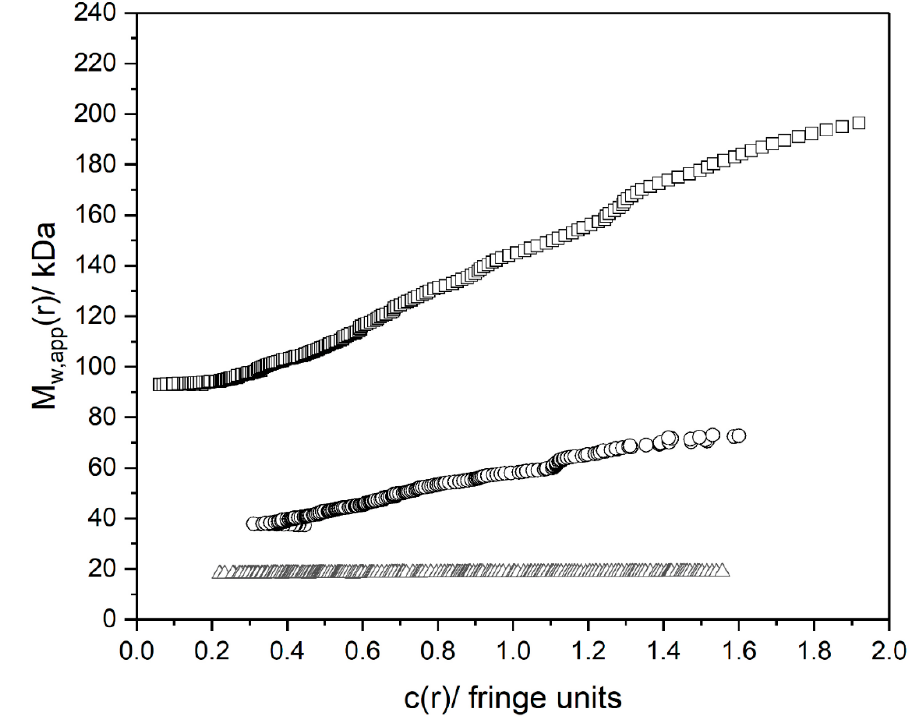
Figure 4. Sedimentation equilibrium analysis (using SEDFIT-MSTAR) on C. moschata polysaccharides. A low loading concentration (to minimise effects of thermodynamic non-ideality) of 0.4 mg/ml (~0.8 fringes in the long path-length cells) was employed. Plots of point weight average molecular weights M w,app ( r ) in kDa vs. local concentration c ( r ) (in Rayleigh fringe units) as functions of radial displacement, r, from the centre of rotation. Squares NJBTF1, Circles NJBTF2, Triangles NJBTF3. M w values (M w,app ) extrapolated to zero concentration = 92 ± 5 kDa (NJBTF1), 31 ± 2 kDa (NJBTF2), and 19 ± 1 kDa (NJBTF3). Solvent: phosphate chloride buffer (pH 7.0, I = 0.1 M), temperature = 20.0 °C.